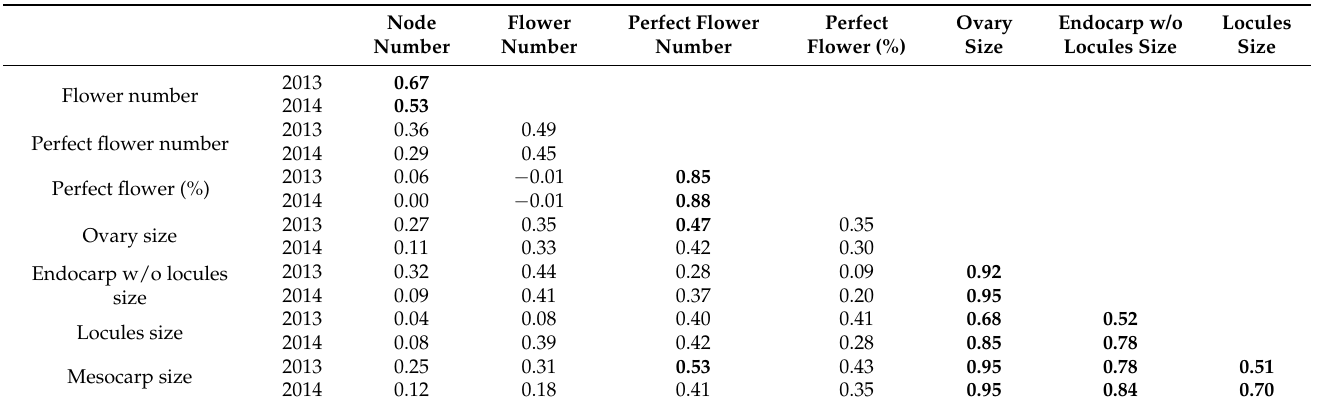
Table 5. Pearson correlation coefficient for inflorescence and ovary parameters evaluated in two consecutive years in the sixteen seedlings and two parents (‘Picual’ and ‘Arbequina’). Significant correlations at p < 0.05 are indicated in bold. Node Flower Perfect Flower Perfect Ovary Endocarp w/o Locules Number Number Number Flower (%) Size Locules Size